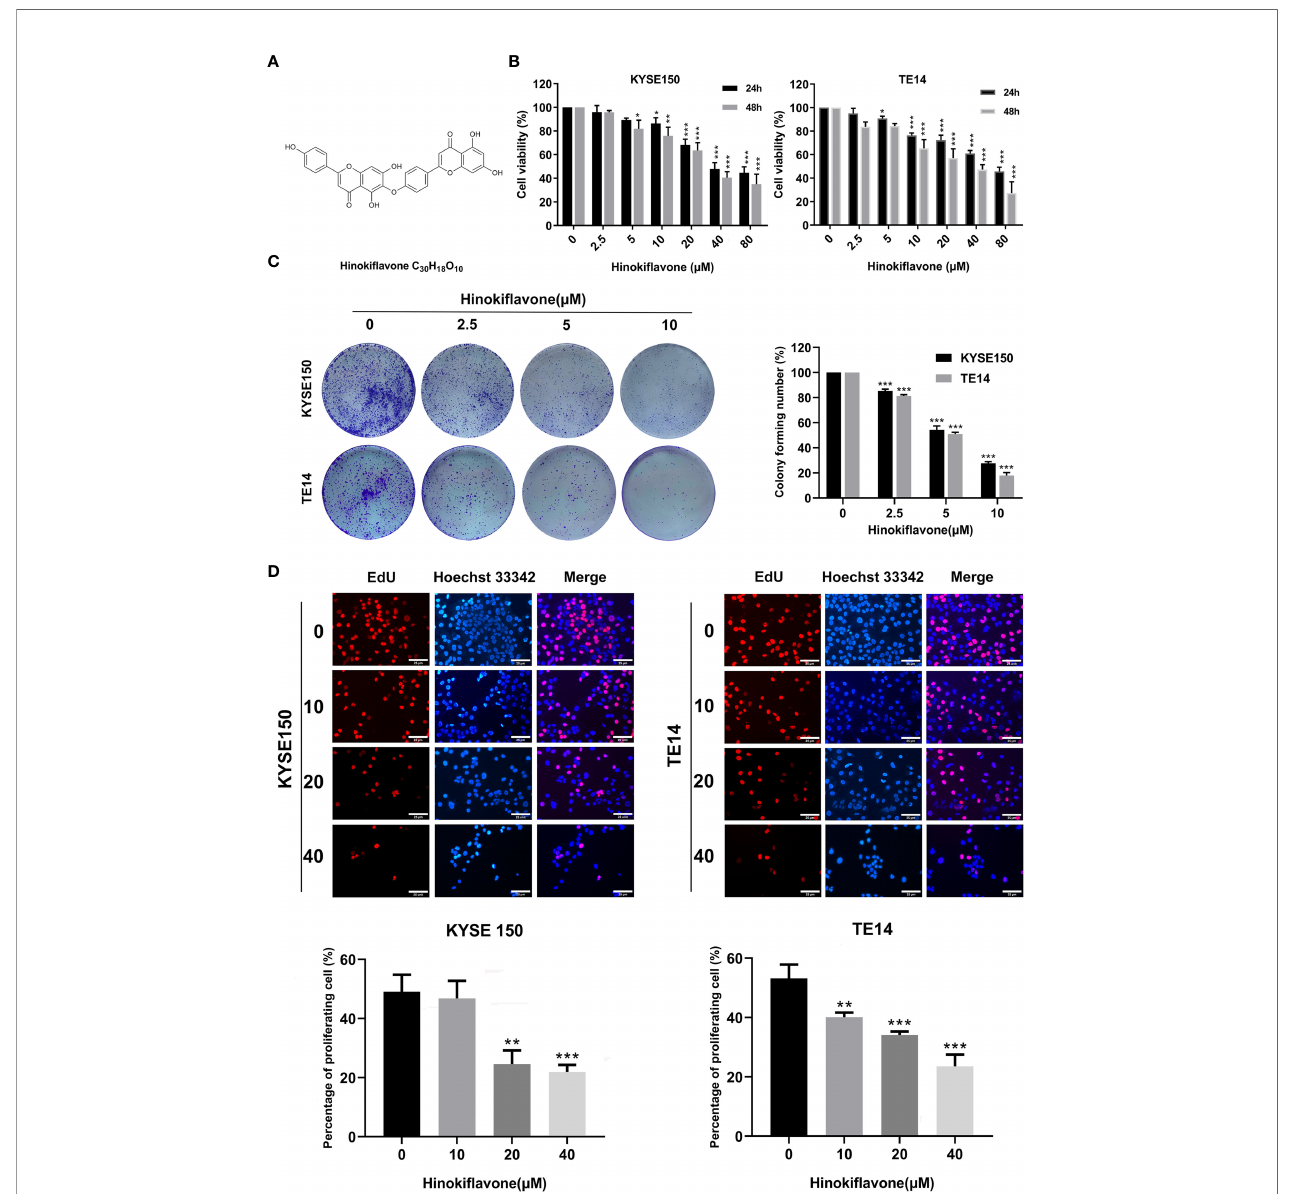
FIGURE 1 | Effect of hinoki fl avone (HF) on the proliferation of esophageal squamous cell carcinoma (ESCC) cells. (A) Two-dimensional chemical structure of HF (C 30 H 18 O 10 ). (B) KYSE150 and TE14 cell lines were incubated with different concentrations of HF for 24 and 48 h Cell viability was evaluated using the CCK-8 assay. (C) HF reduced colony formation of ESCC cells. KYSE150 and TE14 cells were treated with 0, 2.5, 5, and 10 m M of HF and cultured for 9 days to form colonies. Colonies were stained with crystal violet and counted. (D) EdU assay analyzed the antiproliferative effect of HF on ESCC cells. Hoechst 33342 cell nuclei dye presented as blue fl uorescence cells represent total cells, and EdU positive cells presented as red fl uorescence represent proliferating cells. Magni fi cation,